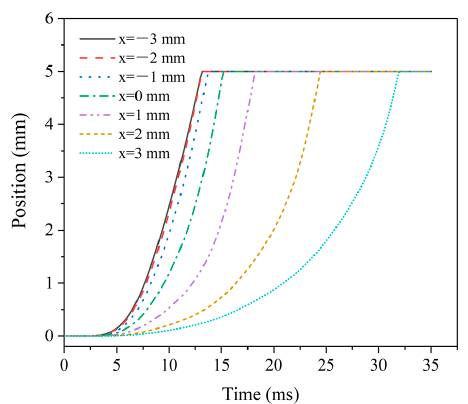
Figure 6. Dynamic displacement curves of MIR at different positions